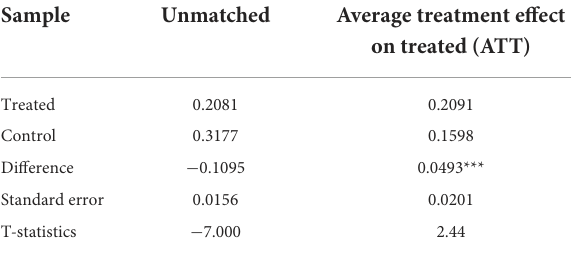
TABLE 5 Effect of health insurance on child